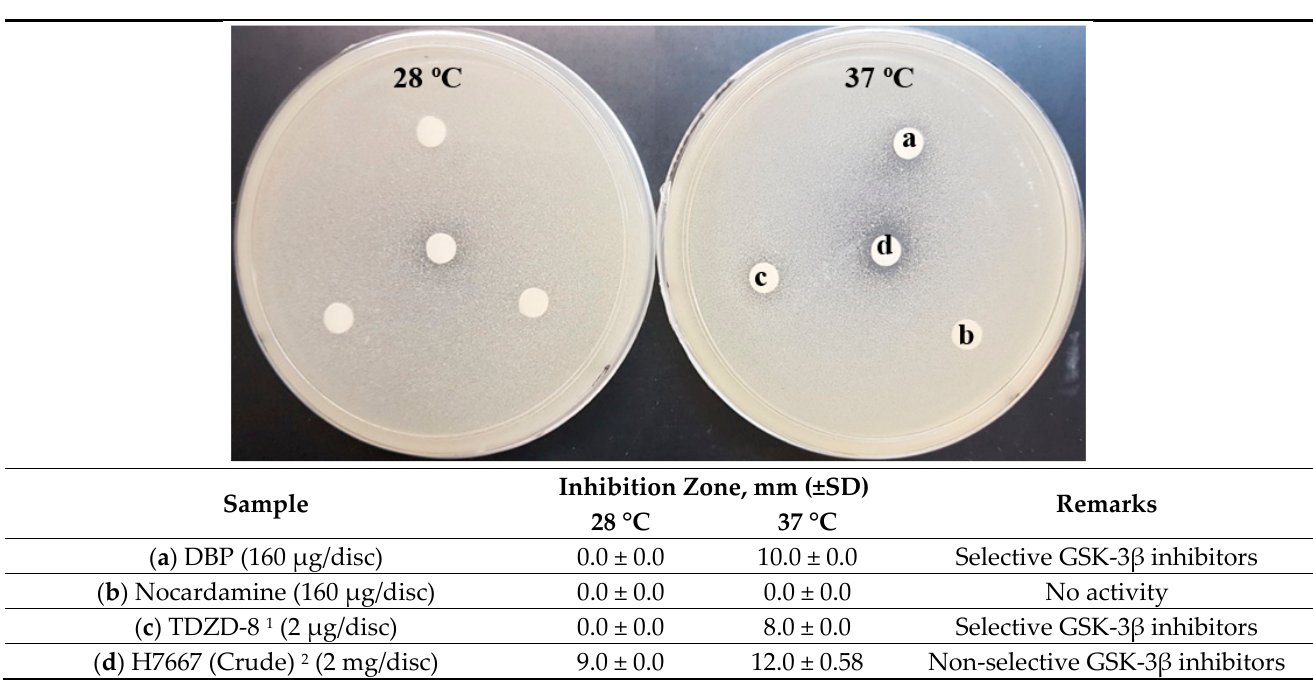
Figure 3. A yeast-based assay to evaluate the inhibitory activity of DBP (a) and nocardamine (b) against Hs GSK-3 β , at 160 µg/disc. “ 1 ” is a selective Hs GSK-3 β inhibitor [24]. “ 2 ” is the extract of Streptomyces sp. H7667, a strain that produces few GSK-3 β inhibitors [18].